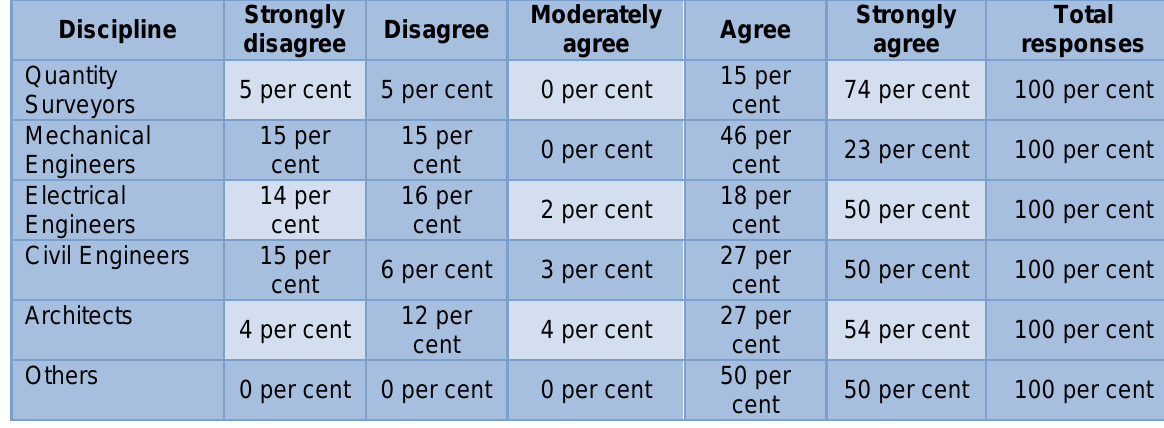
Table 1 Practitioners’ Perception on the Adoption of SBPM for M&E